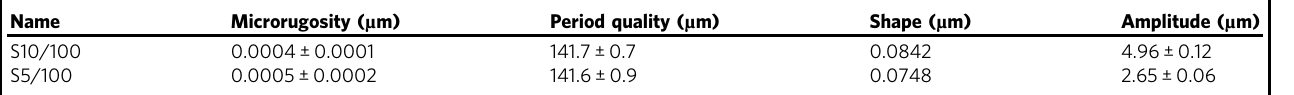
Fig. 1 A two-step process for generation of ultra-smooth 3D sinusoidal topographies. a , b The surface can be described by the sum of two sinusoidal functions that are perpendicular to each other in a plane. c The image shows the result with 1:1:1 aspect ratio. d The fabrication process, simulated in d , consists in the creation of a preform through mask electrochemical micro machining (step 1) that is then smoothed out by mass transport-limited dissolution (step 2). Interferometric measurements ( e , experimental) were compared to the corresponding numerical function. The residual topography ( e , experimental minus numerical) shows that the surface is close to a sinusoidal function. Subtraction of long wavelength using a high-pass fi lter shows that the surface has a very low nanometric roughness ( f ) Table 1 Topographical measurements for S10/100 and S5/100